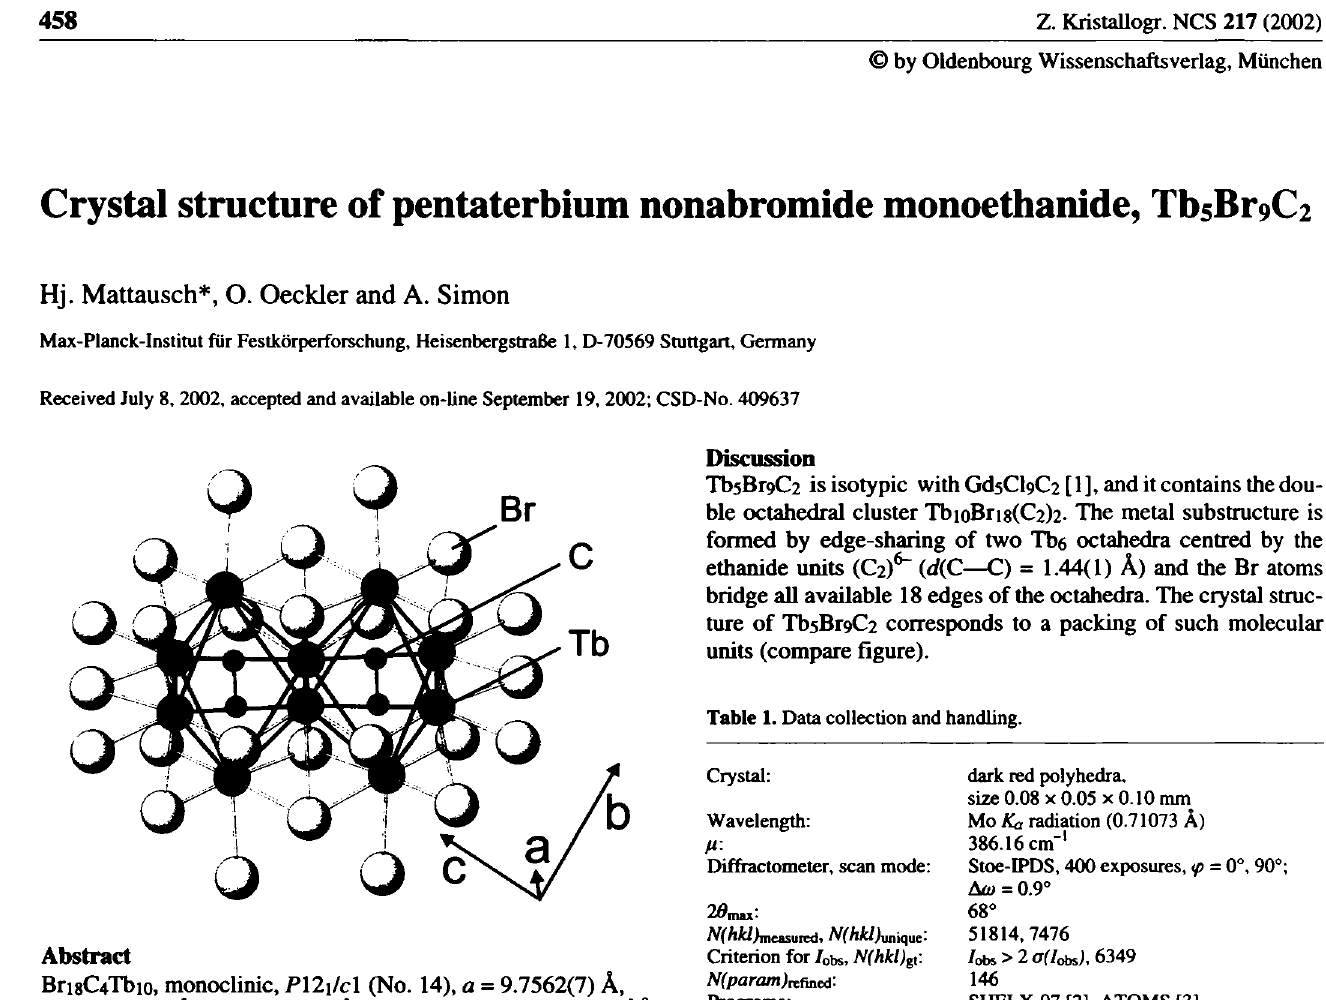
Table 2. Atomic coordinates and displacement parameters (in Â 2